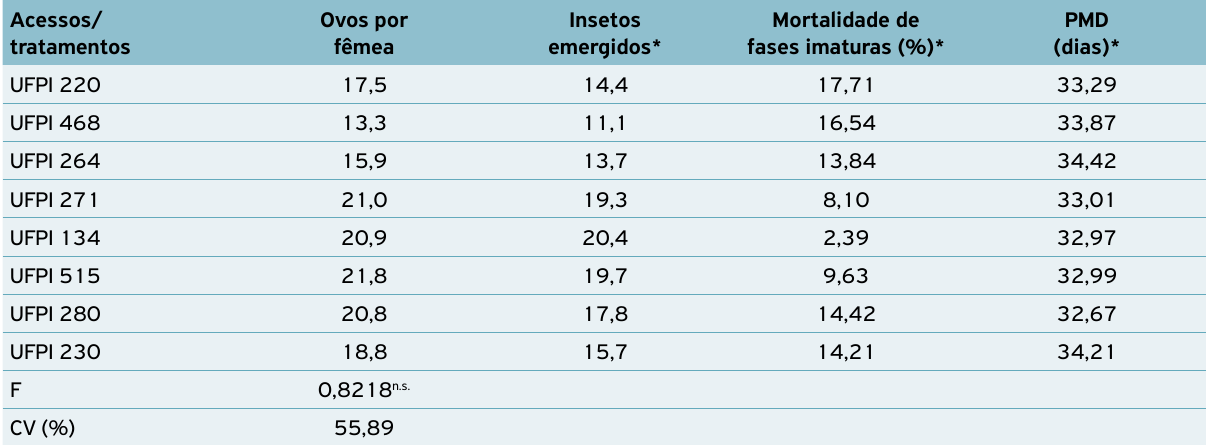
Tabela 1. Médias de dez repetições; ovos por fêmea e insetos emergidos. Percentual de mortalidade de fases imaturas e